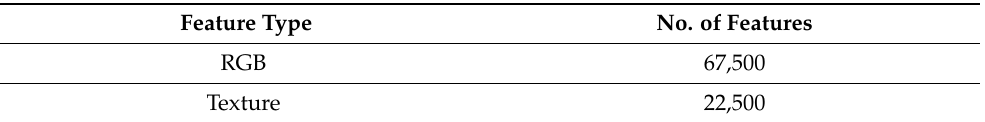
Table 3. Number of features with individual